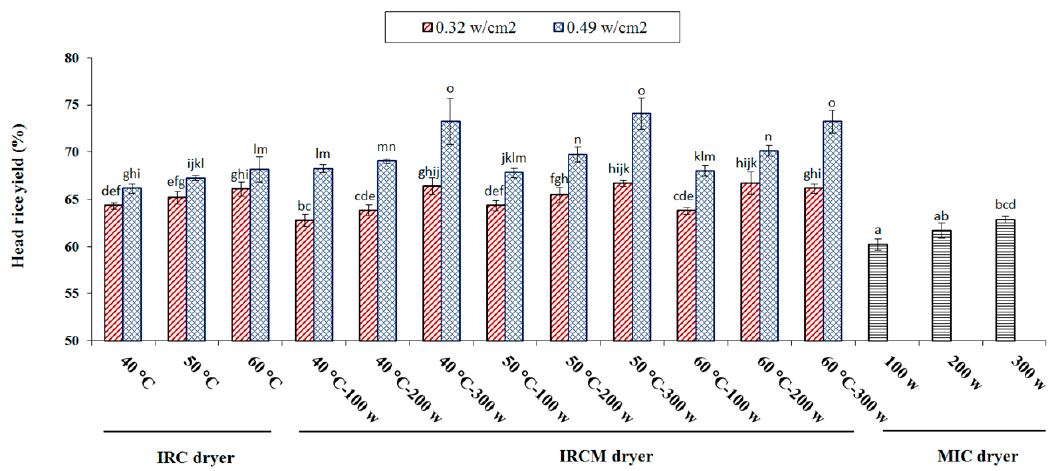
Figure 4. The HRY a ff ected by di ff erent drying methods for parboiled rice drying. Note: The same Figure 4. The HRY affected by different drying methods for parboiled rice drying. Note: The same letter over column shows that the mean amount had no significant di ff erence ( p < 0.05) based on letter over column shows that the mean amount had no significant difference ( p < 0.05) based on Duncan’s test. The error bars represent standard error of the Duncan’s test. The error bars represent standard error of the means.